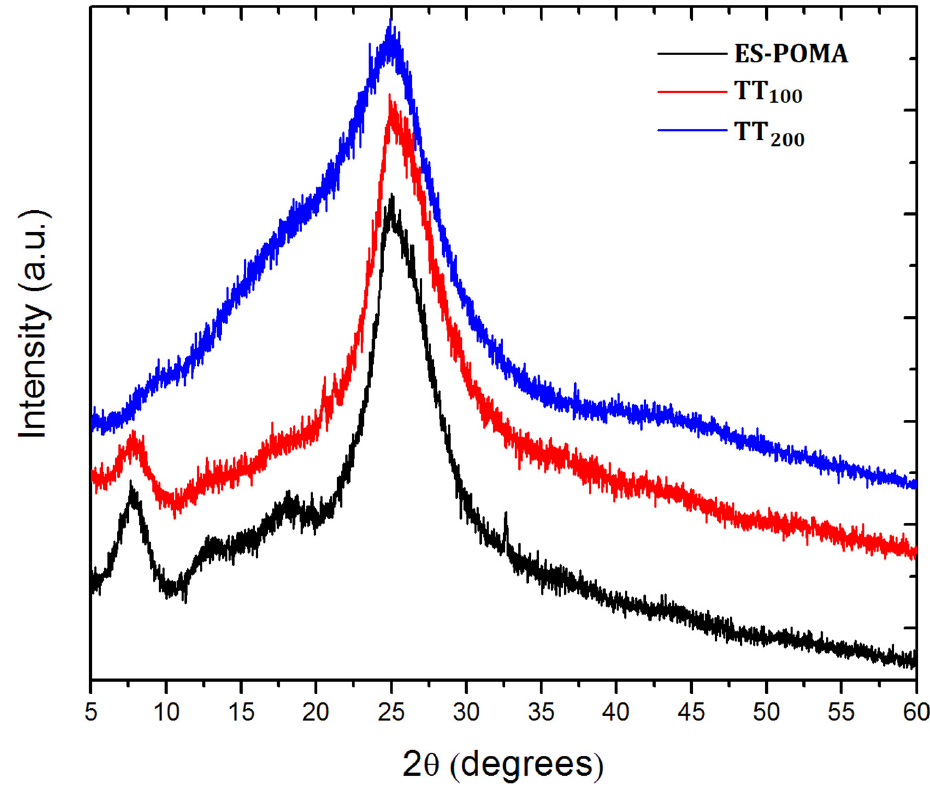
Figure 1. XRD patterns of the untreated (ES-POMA) and treated POMA at 100 °C (TT 100 ) and 200 °C (TT 200 ).